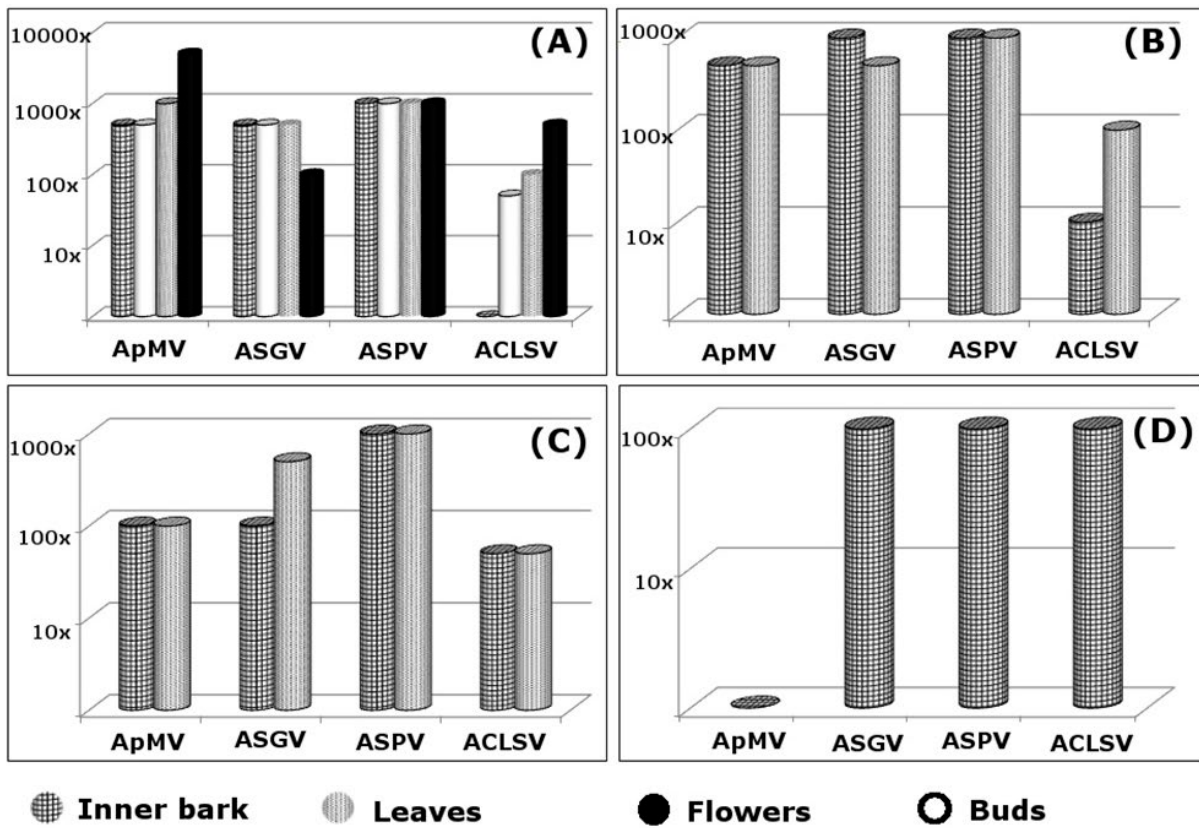
Figure 5. Comparison of the relative concentrations of Apple mosaic virus , Apple stem grooving virus , Apple stem pitting virus and Apple chlorotic leaf spot virus in different plant tissues using RT-PCR throughout 2014. (A): spring; (B): summer; (C): au- tumn and (D): winter. The relative concentration is symbolized in the y-axis and is expressed by logarithm dilution series (10×, 50×, 100×, 500×, 1000×, 5000× and